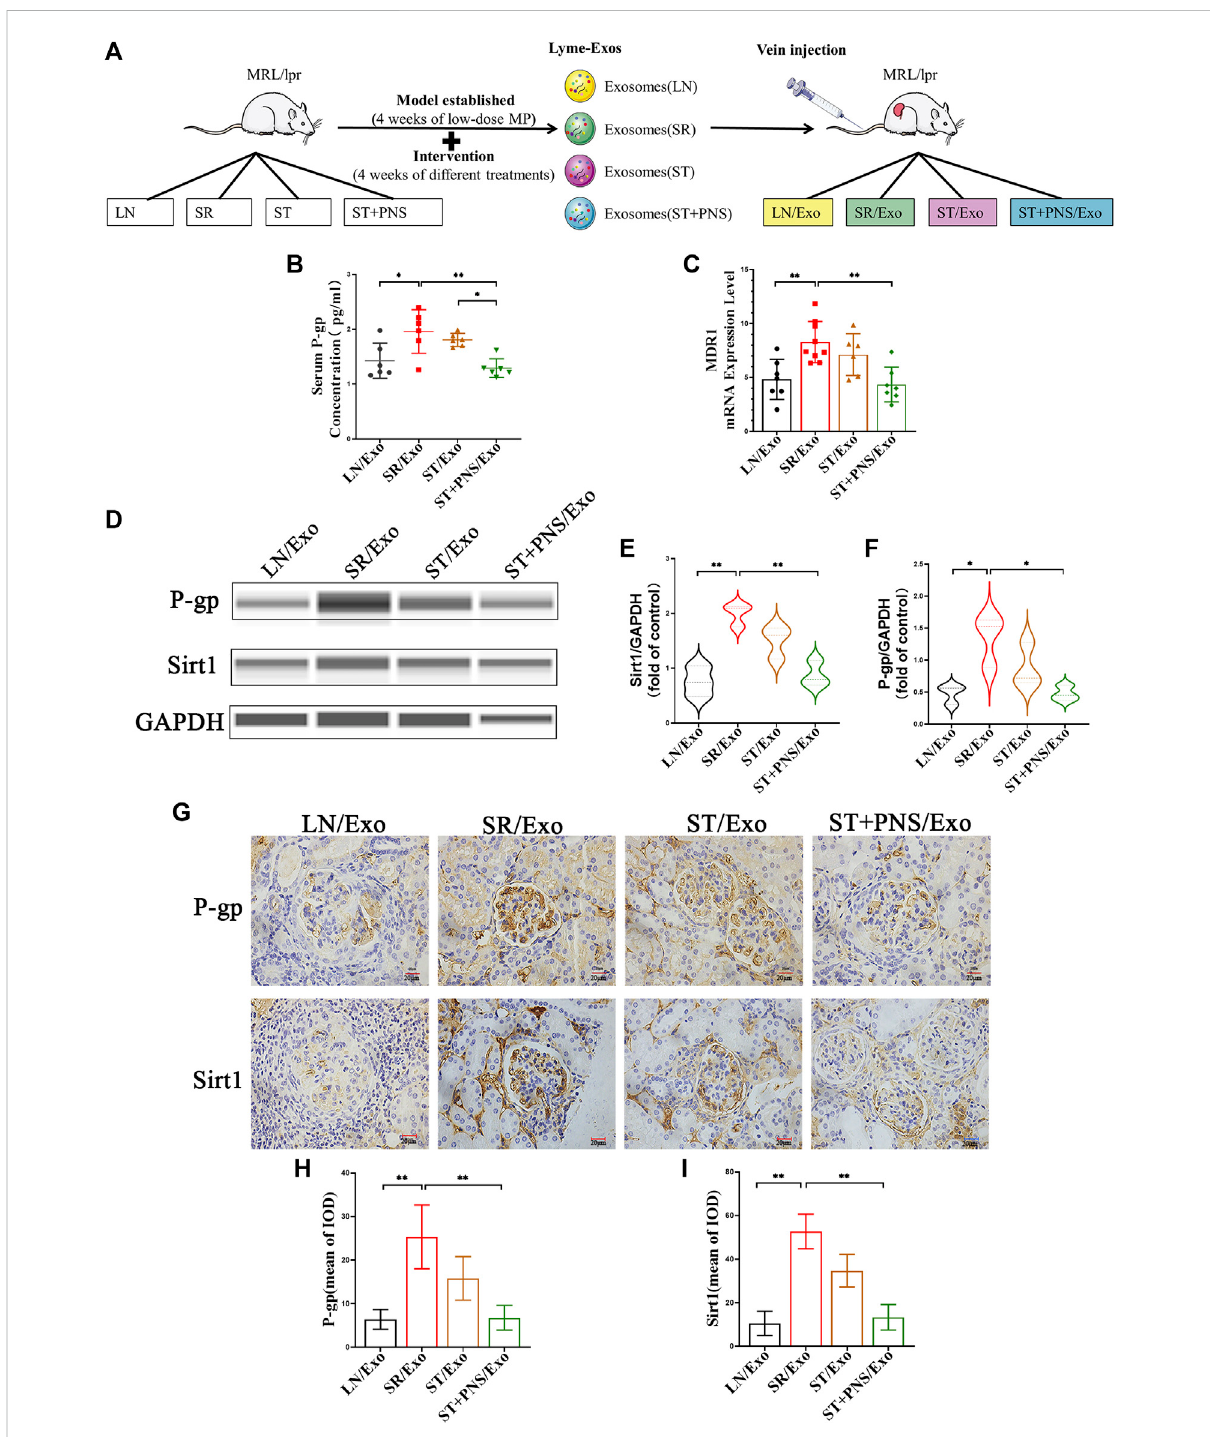
FIGURE 3 Information expression on drug resistance in serum and renal tissue after Lyme-Exo treatment. (A) Treatment fl ow chart and grouping information. (B) ELISA for serum P-gp levels. (C) Detection of MDR1 gene expression of renal tissue by qRT-PCR. (D – F) Capillary immunoassay analysisofSirt1andP-gpproteinlevelsofrenaltissue. (G – I) Sirt1andP-gpimmunohistochemicalstaining(scalebar20 μ m).Alldataareexpressedas the mean ± standard deviation from independent groups, *p < 0.05, **p <